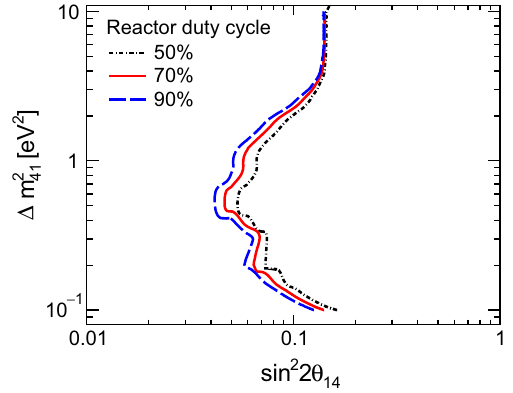
− sin 2 2 θ − sin 2 2 θ Fig. 8 The 90% C.L. exclusion limits in the Δ m 2 14 plane, 14 plane, 41 41 ( 1 − U ) 2 , expected from 1ton-year of the ( 1 − U ) 2 , expected from 1ton-year of the where sin 2 2 θ 14 = 4 U 2 e 4 e 4 e 4 e 4 data at different duty cycle of the reactor ν e event statistics gets affected. Hence, sensitivity of the sterile neutrino oscillation decreases with lower duty